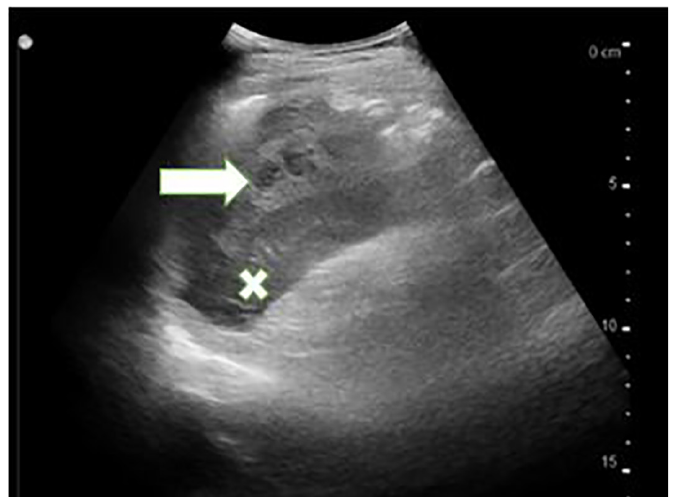
Image 1. Point-of-care ultrasound of the spleen (X) with mixed hypoechoic densities within the splenic capsule (arrow).